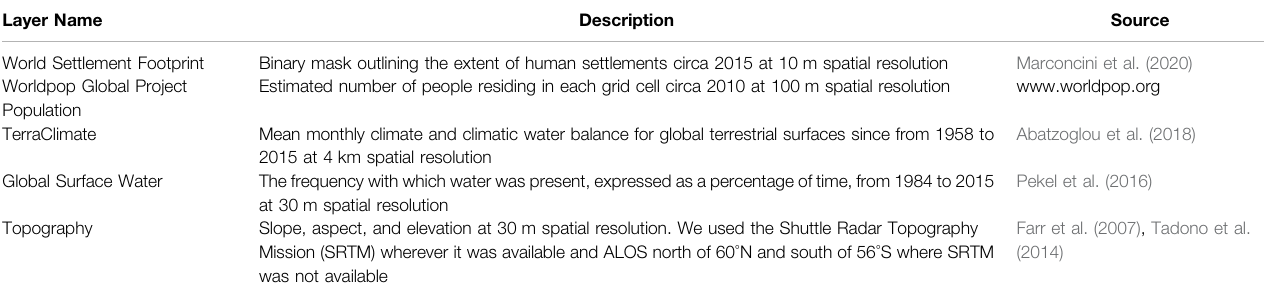
TABLE 2 | List of ancillary data layers used to complement information from Landsat derived from CCDC in the GLanCE mapping